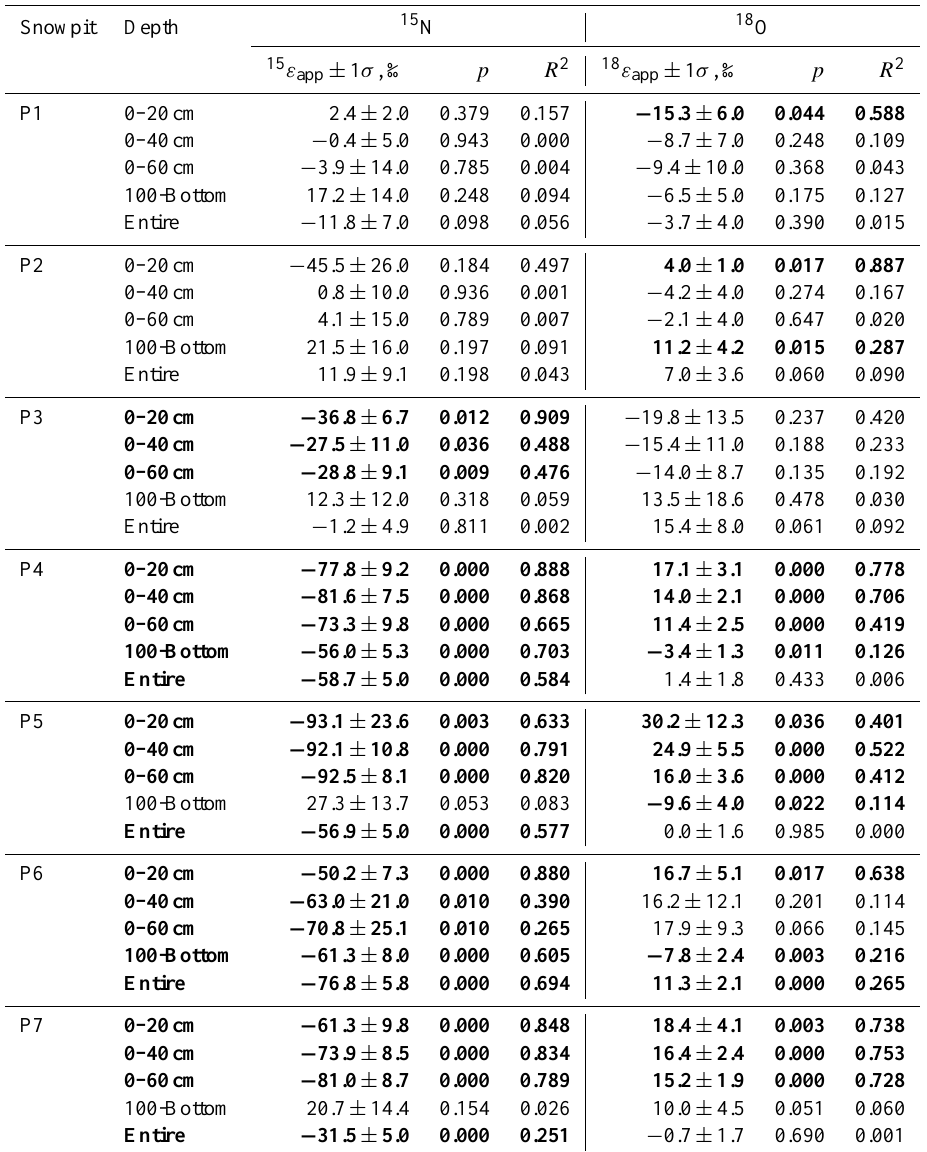
Table 2. Observed fractionation constants for 15 N and 18 O of NO − ( 15 ε app and 18 ε app ) calculated for different snow layer depths from 3 the linear regression of ln( δ snow + 1) vs. ln( w snow ) in Eq. (2). Five different depth intervals were selected for calculating ε app : 0–20, 0–40, 0–60cm, 100cm-bottom and the entire pit. Also given are the standard error (1 σ ), R 2 values and the significance level, p , where bolded values represent p